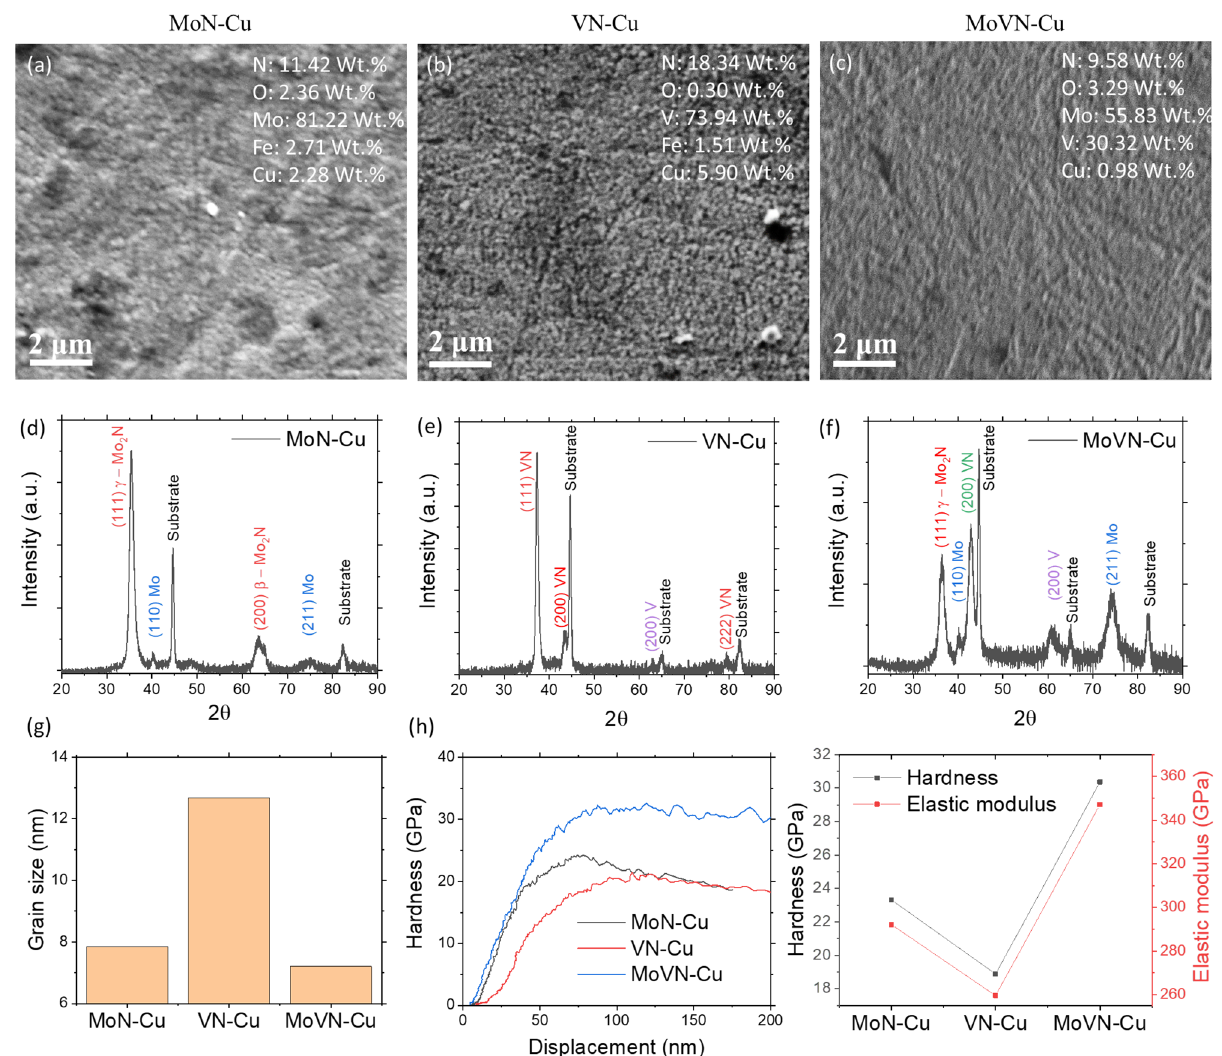
Figure 1. Surface morphology and EDS elemental composition analysis of ( a ) MoN-Cu, ( b ) VN-Cu, and ( c ) MoVN-Cu films. XRD analysis of the ( d ) MoN-Cu, ( e ) VN-Cu, ( f ) MoVN-Cu films, and the calculated